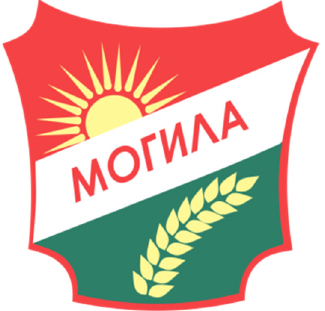
Figure 15. Arms with Kutlesh-type sun: Mogila